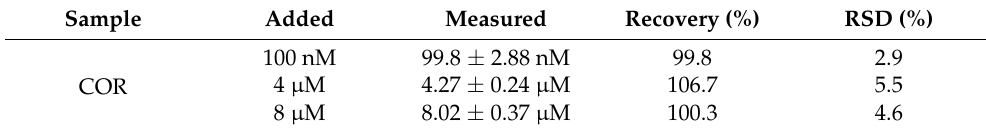
Figure 4. ( A ) Fluorescence spectra of PPIX in the presence of various concentrations of COR by using 1% FBS as the reaction solution; ( B ) Fluorescence spectra of Py in the presence of various concentrations of COR by using 1% FBS as the reaction solution; ( C ) Linear relationship between the F 642 /F 383 ratio and COR’s concentrations in the range from 100 nM to 8 µ M by using 1% FBS as the reaction solution. The error bars are obtained via three independent experiments. Table 2. Recovery test results of this sensor in fetal bovine serum (FBS)